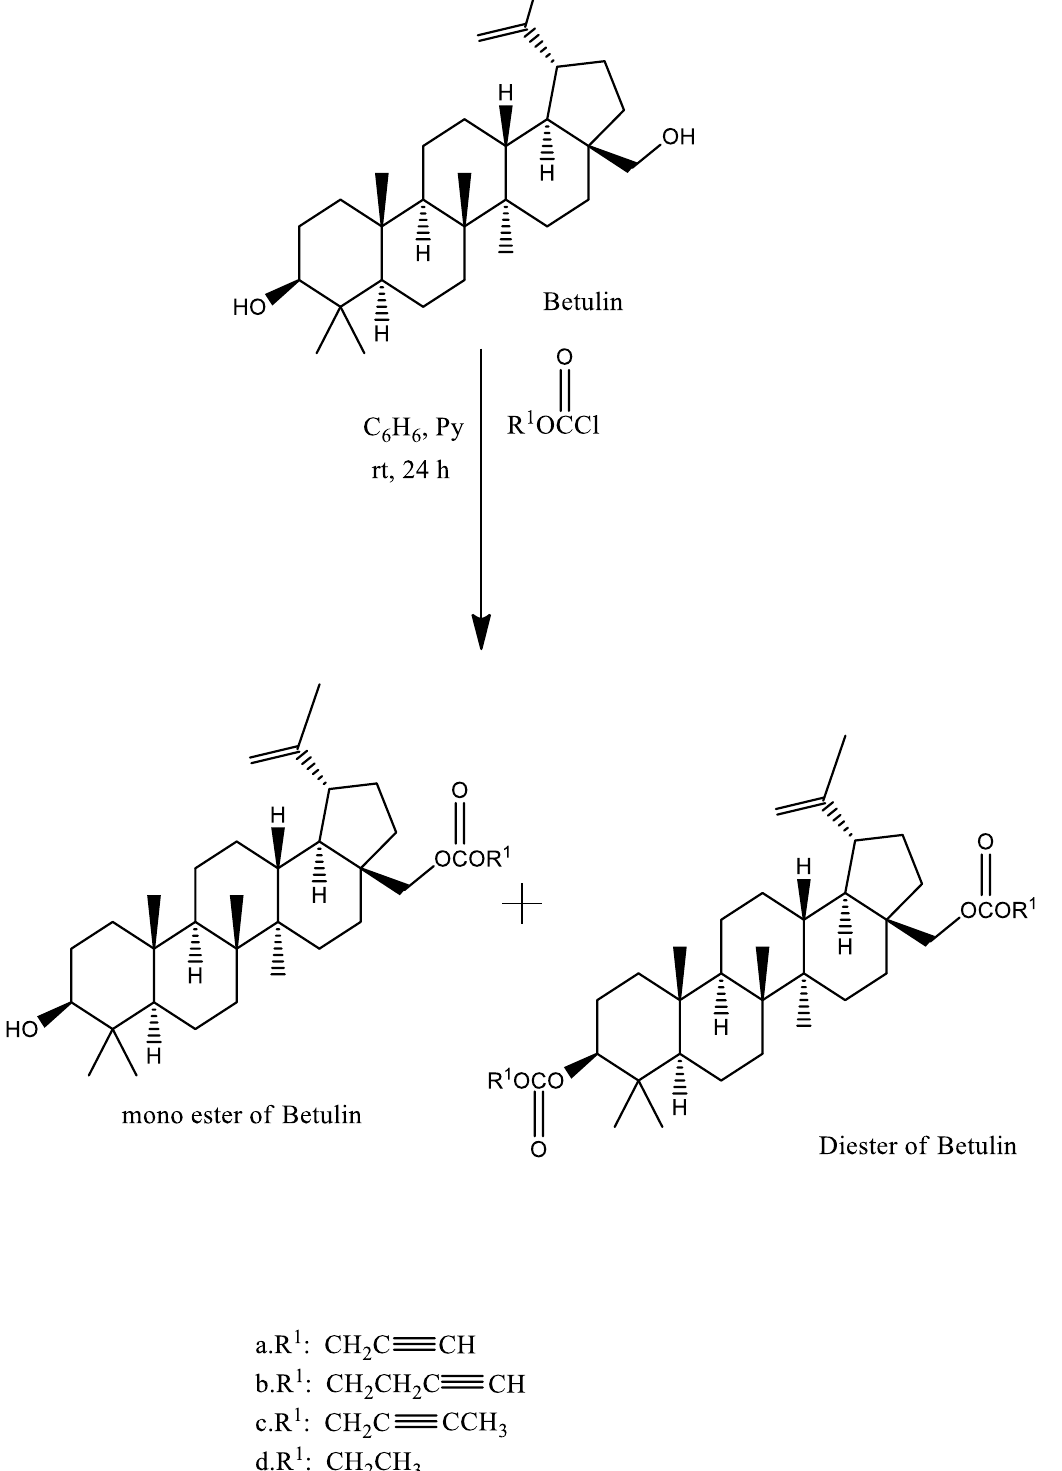
Figure 2. Synthesis of acetylenic derivatives of Betulin.